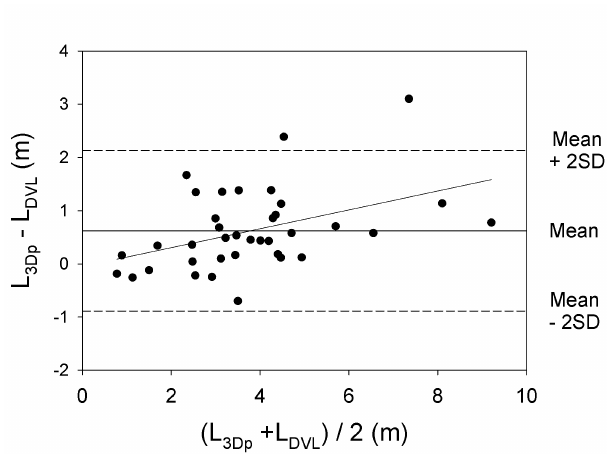
Fig. 10. Bland and Altman plot of difference against mean for the projected subtransect length in PhotoModeler ( L 3Dp ) and the sub- transect length measured from bottom tracking ( L DVL